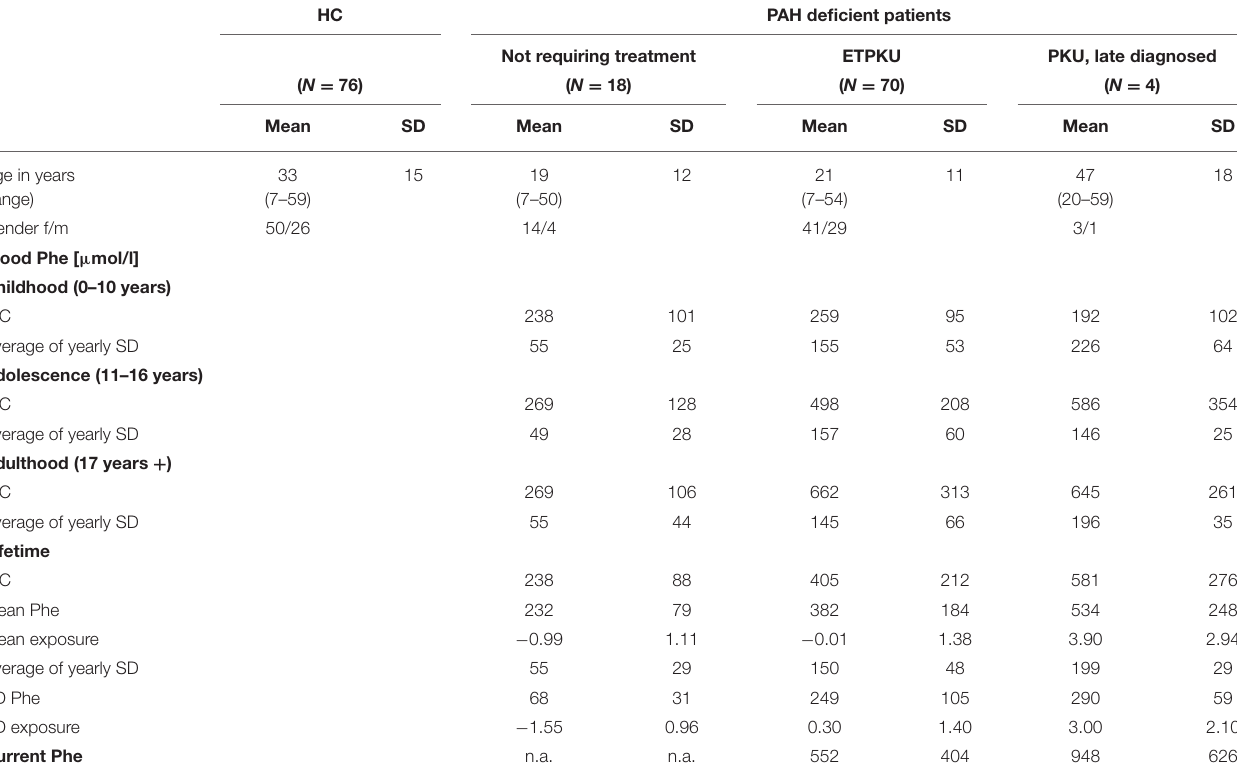
TABLE 1 | Demographic information of cohorts and phenylalanine indices of the phenylalanine hydroxylase (PAH) deficient patient groups. HC PAH deficient